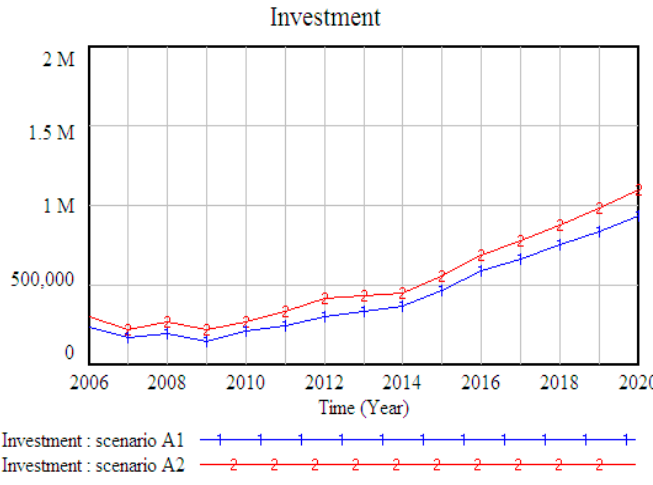
Figure 2. Sales of natural gas (billion cubic meters).